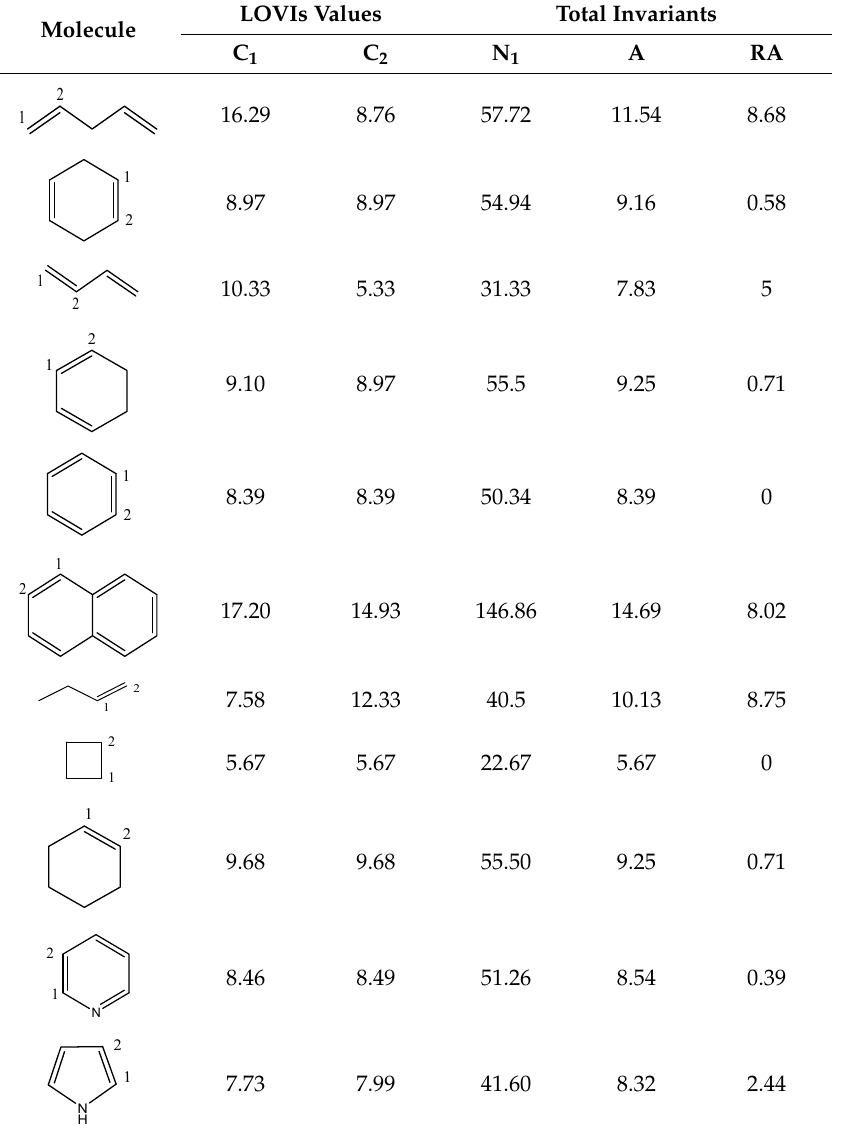
Table 5. Codification of cyclization, conjugation and aromaticity. Molecule